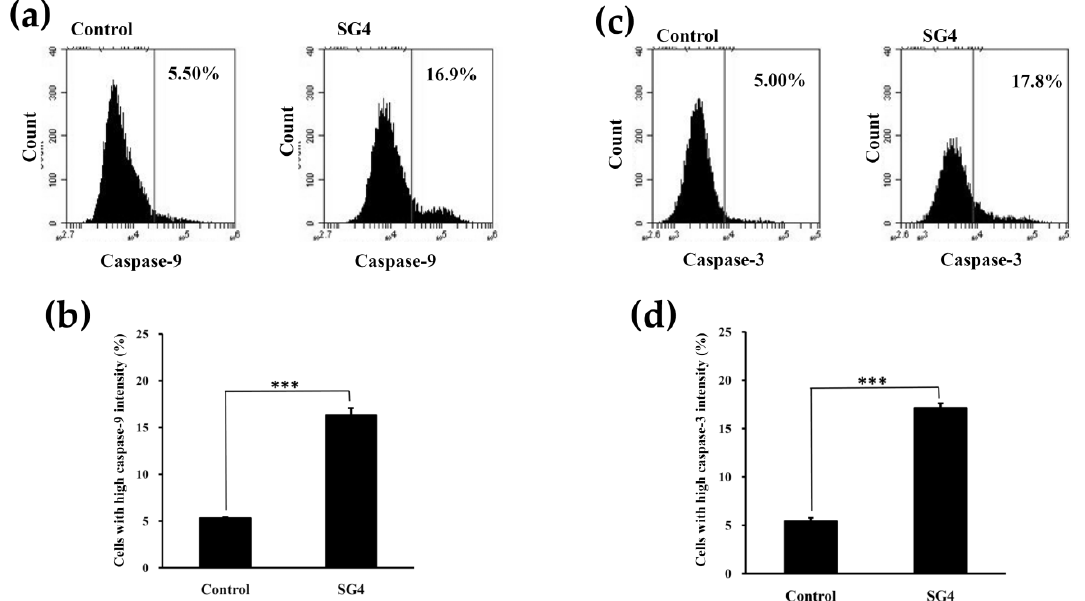
Figure 4. The expression of active caspase-9 and -3 in HT-29 cells treated with 200 µ g / mL SG4 for 48 h: ( a ) In the histograms, x axis and y axis denote caspase-9 content and cell counts, respectively. The percentage of cells with mean channel fluorescence values above the marker border is indicated in each histogram; ( b ) the percentage of cells with high fluorescence of caspase-9 is presented as determined for ( a ). ( c ) In the histograms, x axis and y axis denote caspase-3 content and cell counts, respectively. The percentage of cells with mean channel fluorescence values above the marker border is indicated in each histogram; ( d ) the percentage of cells with high fluorescence of caspase-3 is presented as determined for ( c ). The experiments were performed in triplicate. *** p < 0.001.